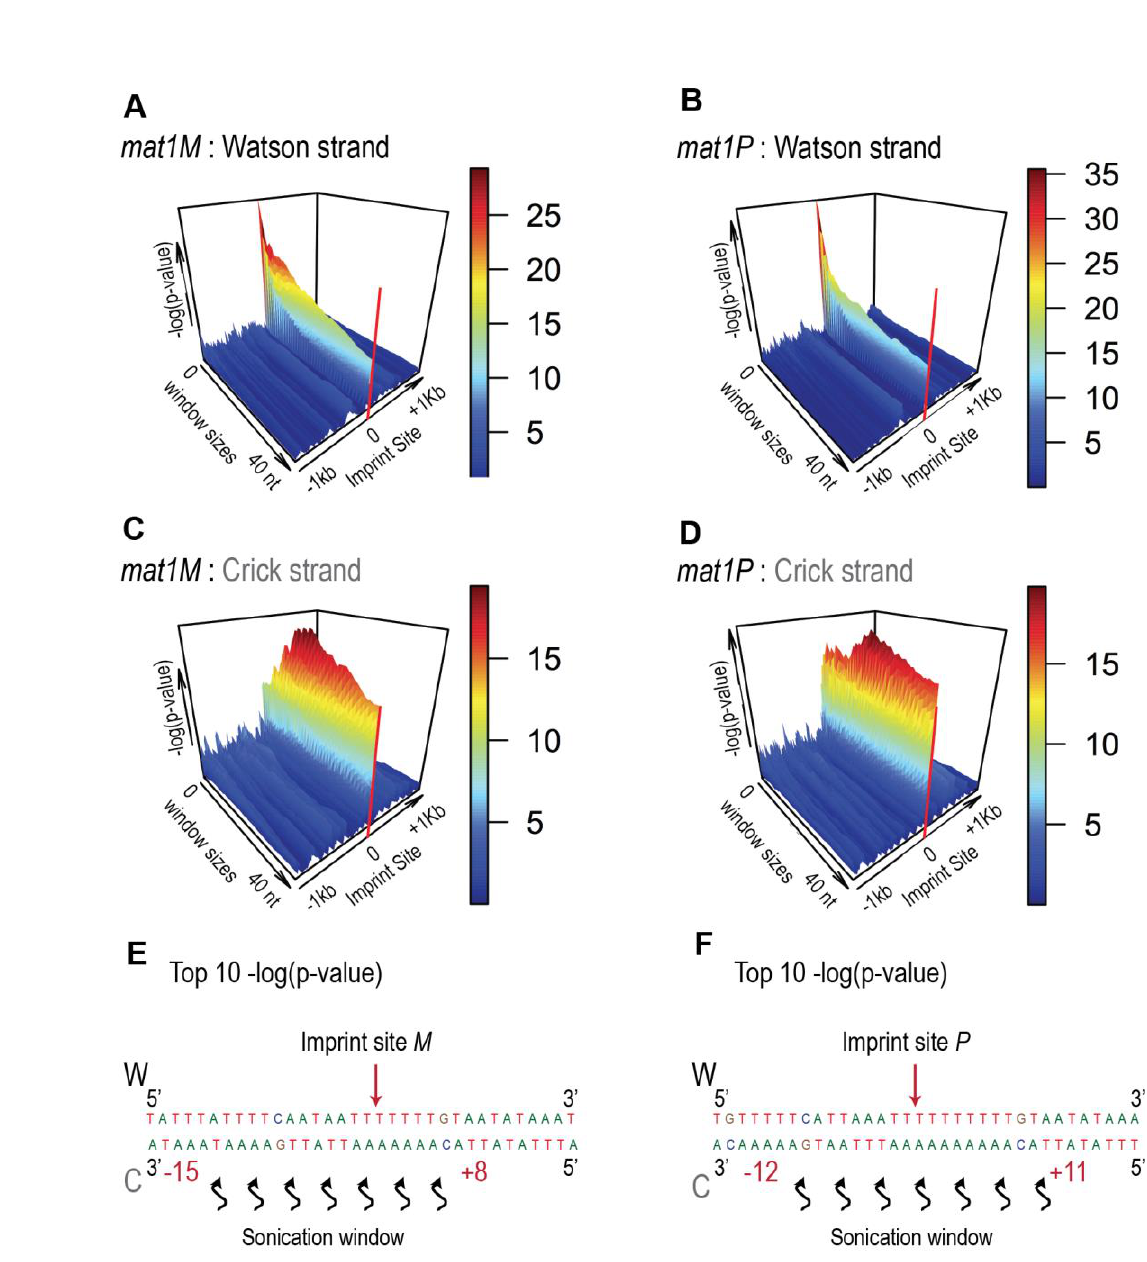
FIGURE 8: Signature of sonication across the imprint. Statistical analysis of the 5' count in the mat1 region. -log(p-value) of 5' count as a function of the window size and genome position is represented. The -log(p-value) scale is indicated on the right of the graphics. The p-value is calculated using theoretical t-student distributions that fit with the distribution of 5' count observe in the 10-kb region that contains mat1 . (A) A sliding window (+/- 1 kb around the imprint site) with step size one and varying window size (1 to 40 nt) is applied when calculating the -log(p-value) of the 5' count of the Watson strand shown. The sequencing of a mat1M ∆ 2-3 strain is used. (B) Same as in (A) for the Crick strand. (C) Window sizes and window positions compared to imprint site for the top 10 -log(p-value) are indicated. (D, E and F) Same as in (A, B and C), respectively for the sequencing of a mat1P ∆ 2-3